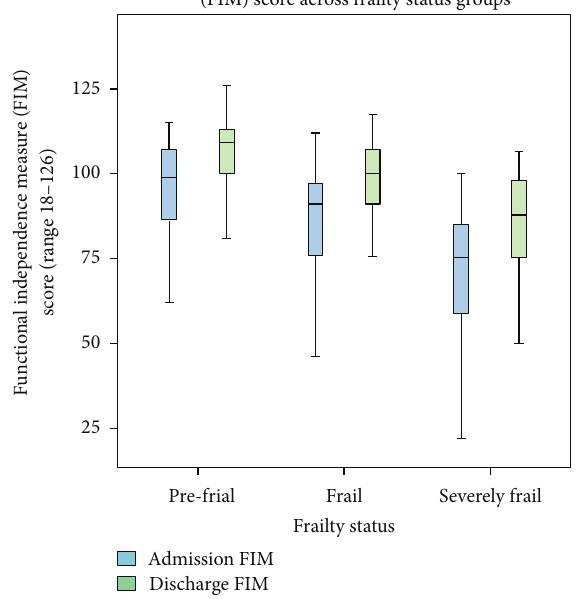
Figure 1: Admission and discharge FIMs against frailty